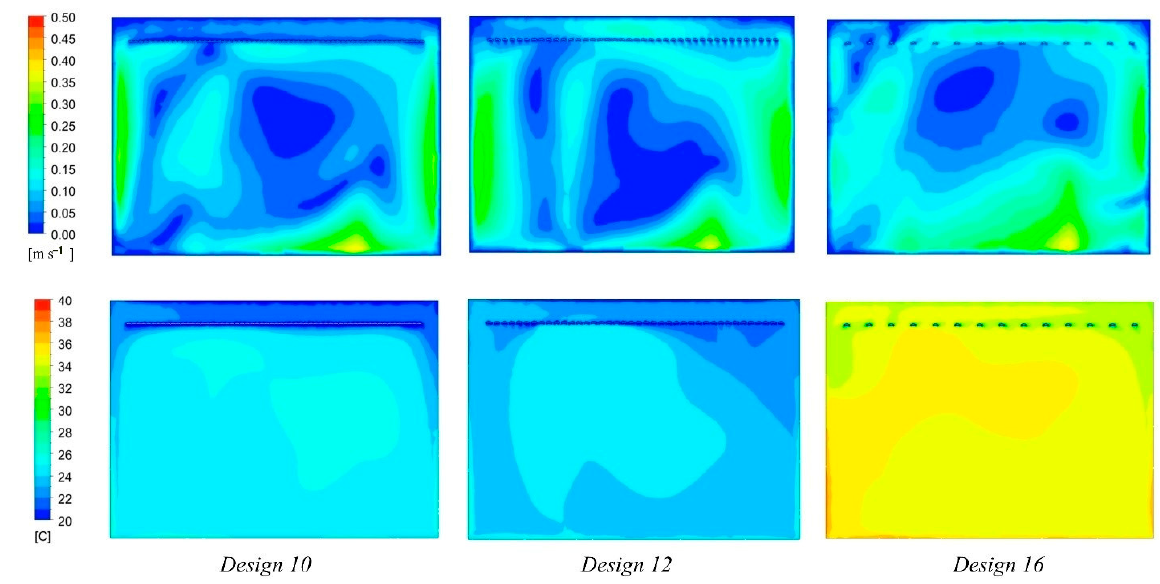
Figure 10. Velocity and temperature contours in Design 10, Design 12, and Design 16 under a cooling load of 1405.02 W.